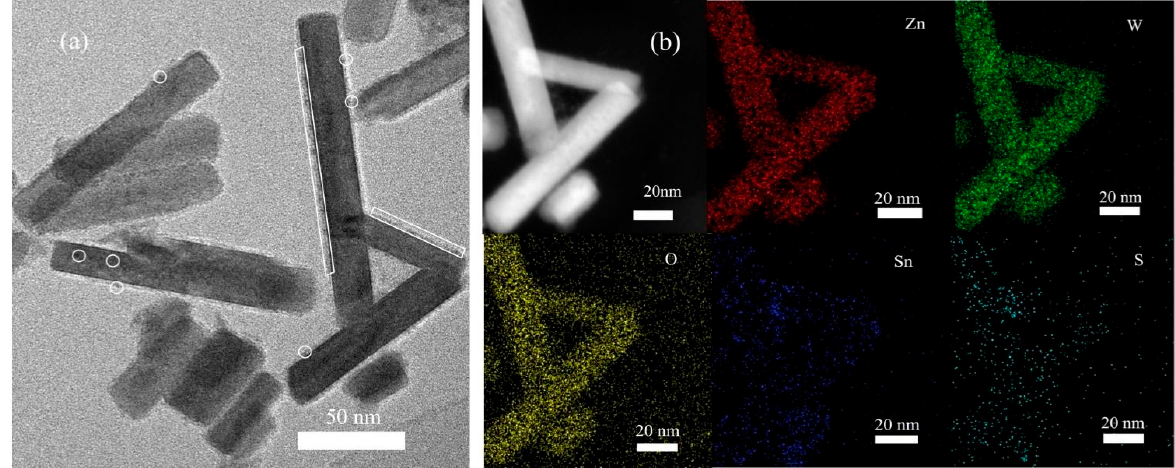
Figure 2. ( a ) HRTEM image of the SZWO-9 sample; ( b ) HAADF-STEM image and EDS elemental mapping images of the SZWO-9 sample.